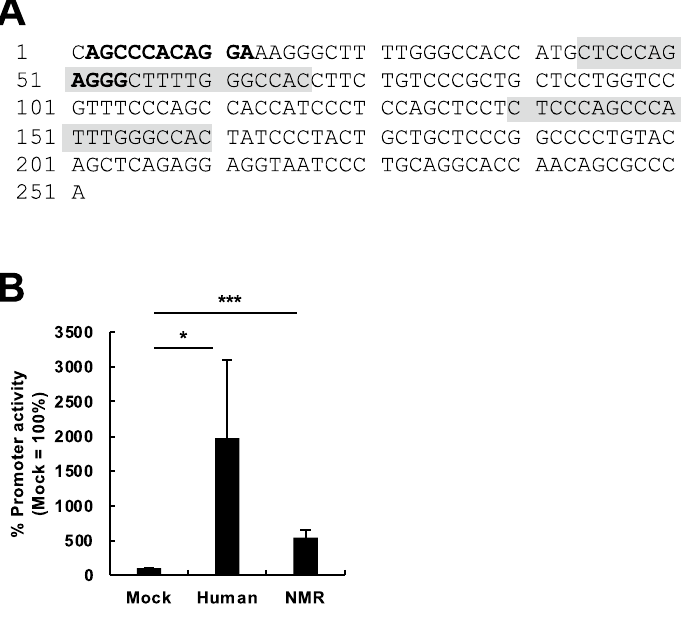
Figure 3. Characterization of the promoter activity of the 5 ′ UTR of NMR-L1. ( A ) Repeat sequences and transcription factor-binding sites in the 5 ′ UTR of NMR-L1. The gray boxes represent the repeated sequences with potential Runx1- and Erg-binding sites in bold. ( B ) The promoter activity of the 5 ′ UTR of NMR-L1. 293T cells were transfected with pGLuc-5 ′ -UTR or pGLuc-NMR-L1-5 ′ -UTR together with pCMV-CLuc.